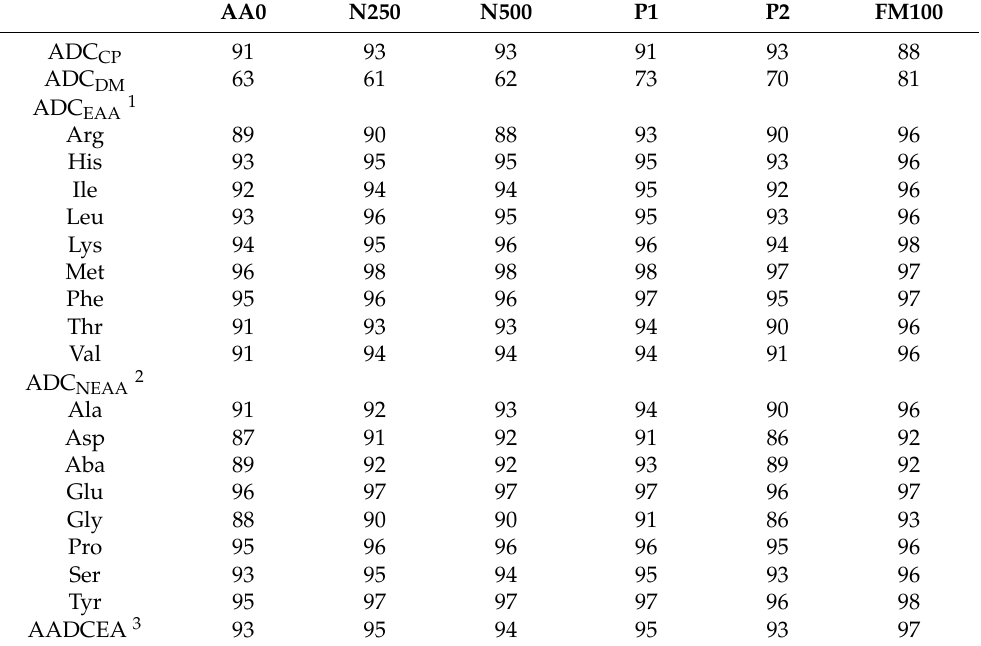
Table 5. Apparent digestibility coefficients (ADC, %) of crude protein (CP), dry matter (DM), and amino acids (AA) in the gilthead seabream fed different experimental